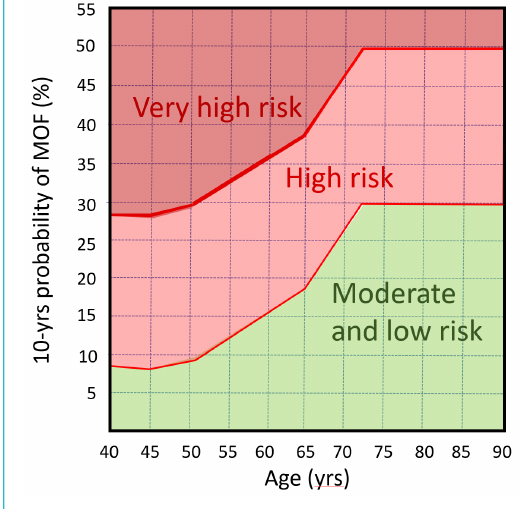
Figure 1: Intervention thresholds for osteoporosis therapy based on the 10-year risk of a major osteoporotic fracture in